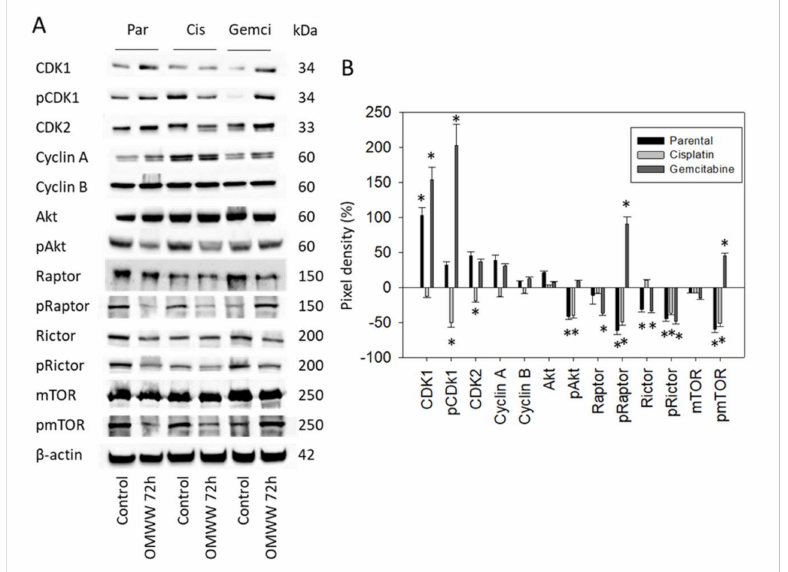
Figure 6. ( A ) Western blot of cell cycle and mTOR related proteins from RT112 lysates of parental and cisplatin/gemcitabine-resistant cells. Tumor cells were pretreated with OMWW (dilution 1:125) for 24 and 72 h (controls remained untreated). β -actin served as the internal control. One representative from three separate experiments. ( B ) The ratio of protein intensity/ β -actin intensity expressed as a percentage of the controls, set to zero. Error bars indicate standard deviation (SD), n = 3. * indicates significant difference to controls.